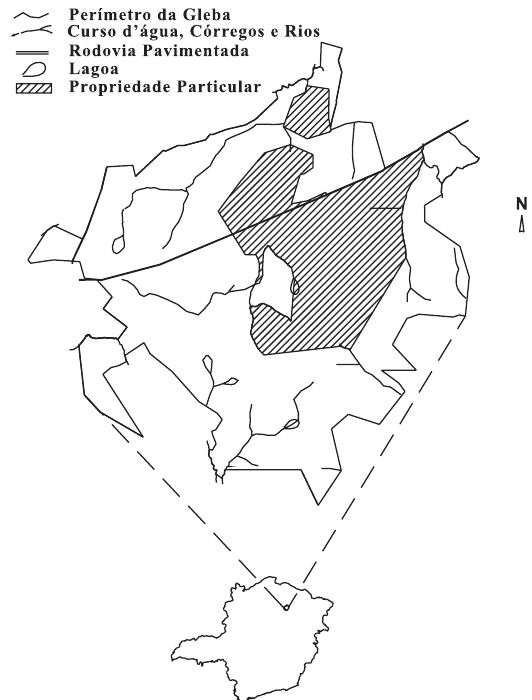
Figura 1. Localização aproximada da área estudada, no Estado de Minas Gerais e detalhes do perímetro e rede hidrográfica do Projeto de Assentamento Americana.